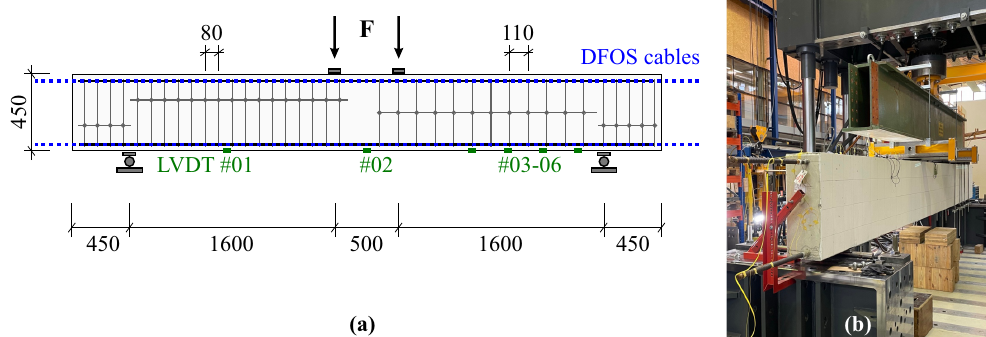
Figure 9. Laboratory beam testing: ( a ) Schematic representation of beam structure (dimensions in mm). ( b ) Instrumented concrete beam mounted at testing